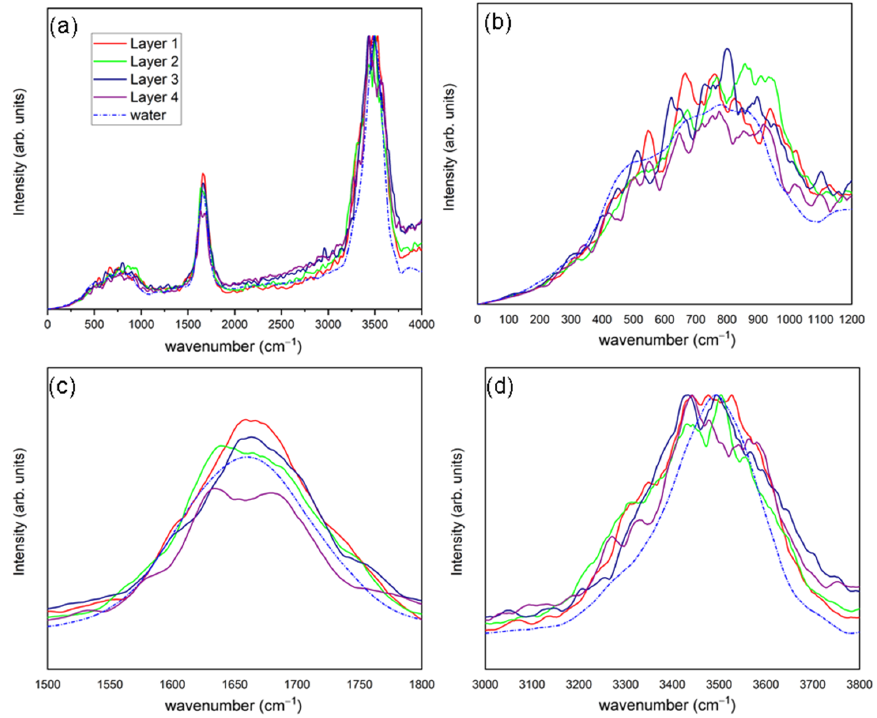
Figure 4. Full infrared spectra ( a ) and subsets for low-frequency region ( b ), H-O-H bending region ( c ) and H-O stretching region ( d ) for first (red), second (green), third (dark blue), and fourth (purple) solvation layers considered and liquid water (blue, line-dot-line).